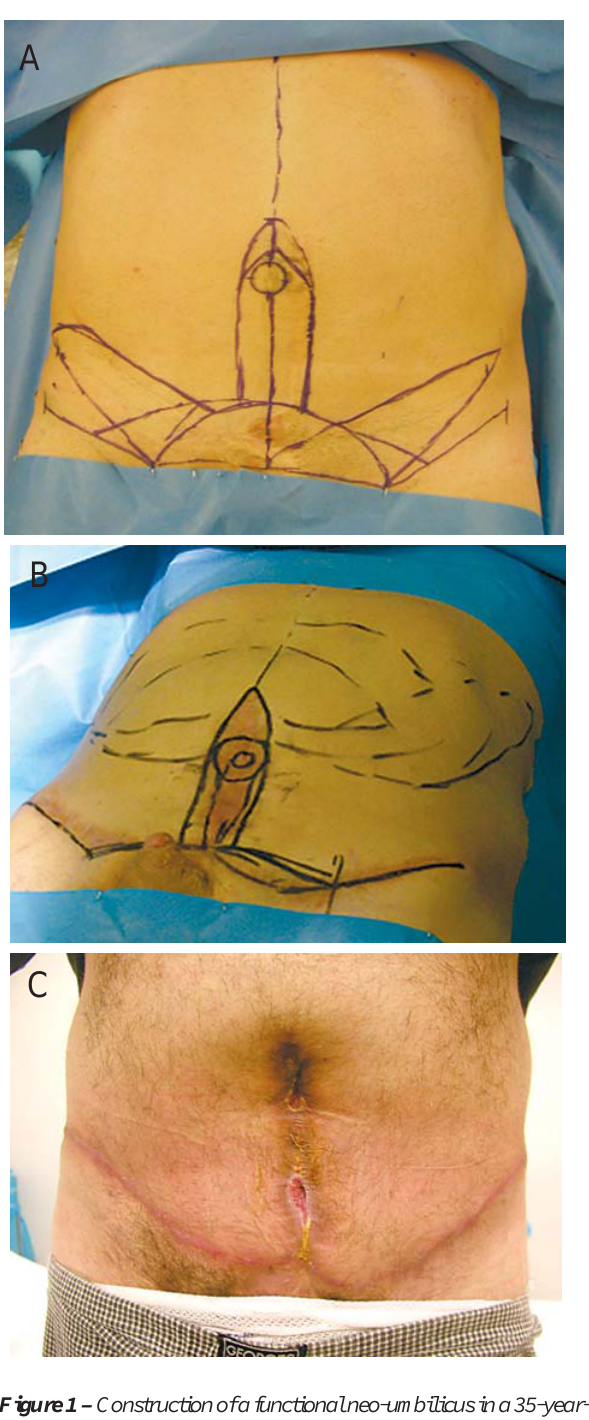
Figure 1 – Construction of a functional neo-umbilicus in a 35-year-old man with previous bladder extrophy treatment. A) Clinical aspect: planning of the 1st stage operation (inverted T-abdominoplasty and neo-umbilicus construction). B) Clinical aspect 6 months after 1st stage operation. C) Clinical aspect: planning of the 2nd stage operation (liposuction and redo neo-umbilicus construction). D) Intraop- erative aspect: modified Mainz I pouch with Monti type continent diversion. E) Clinical aspect 6 months after 2nd stage operation: aesthetic